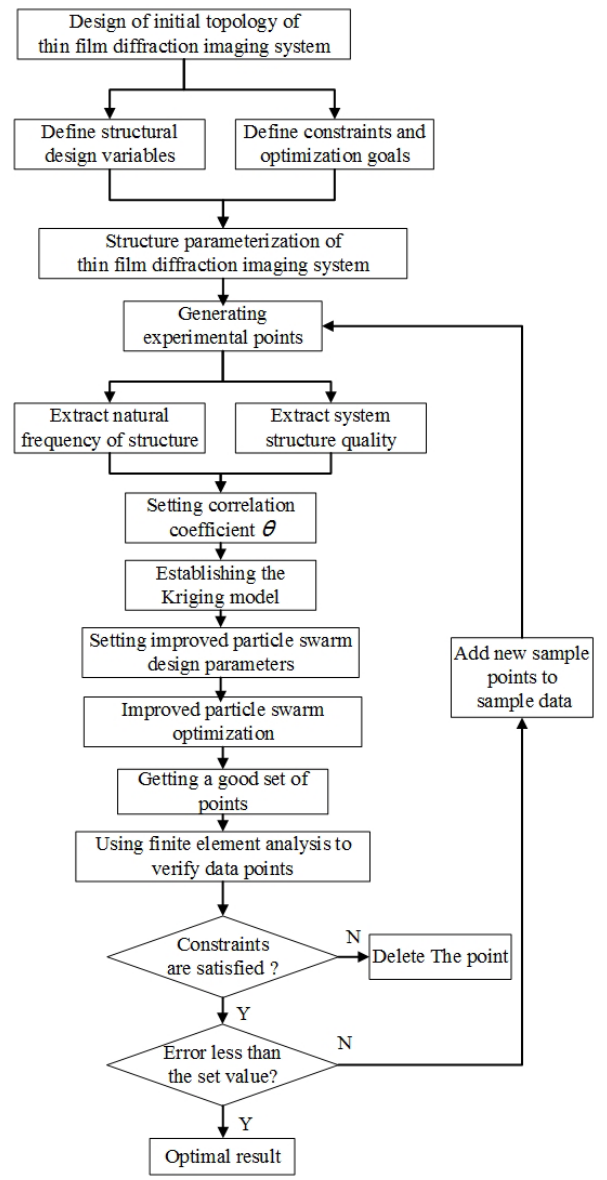
Figure 4. Flow chart of the global optimization based on the Krig- ing